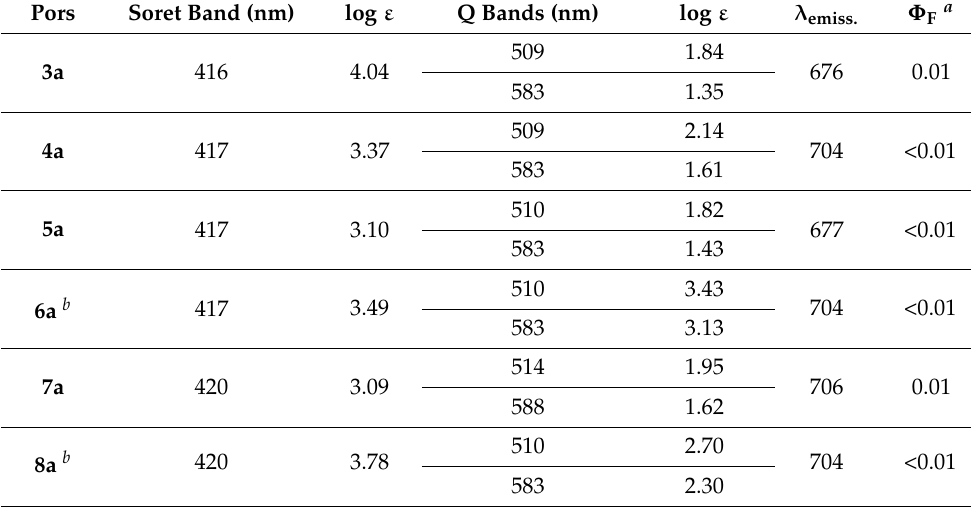
Table 1. Absorption and emissive properties of Pors 3a – 8a in DMSO. Pors Soret Band (nm) log ε Q Bands (nm) log ε λ emiss.